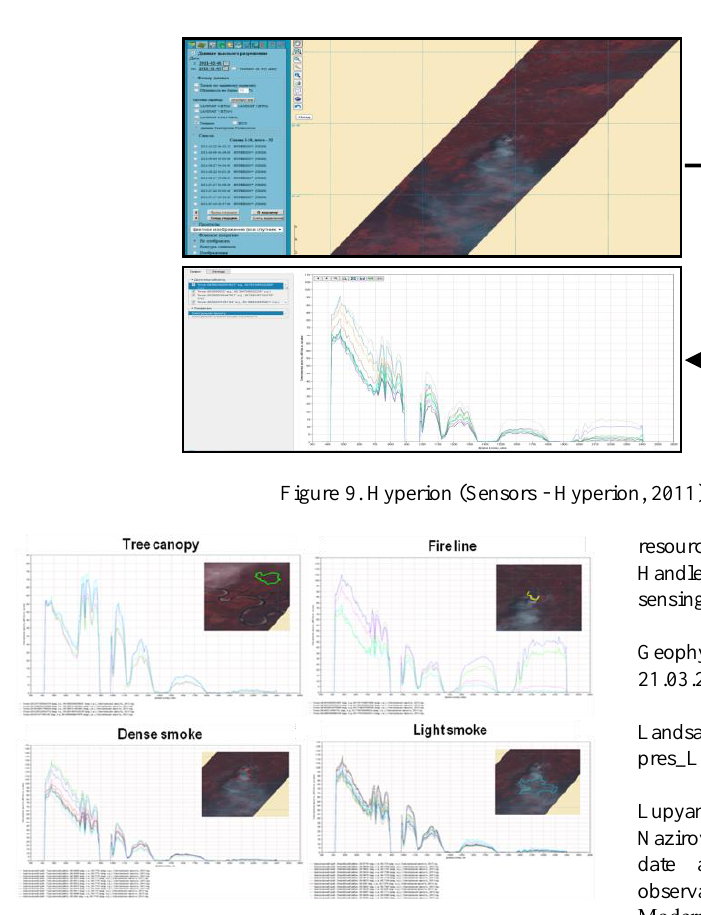
Figure 10. Hyperion (Sensors - Hyperion, 2011) spectral profiles in the area of forest